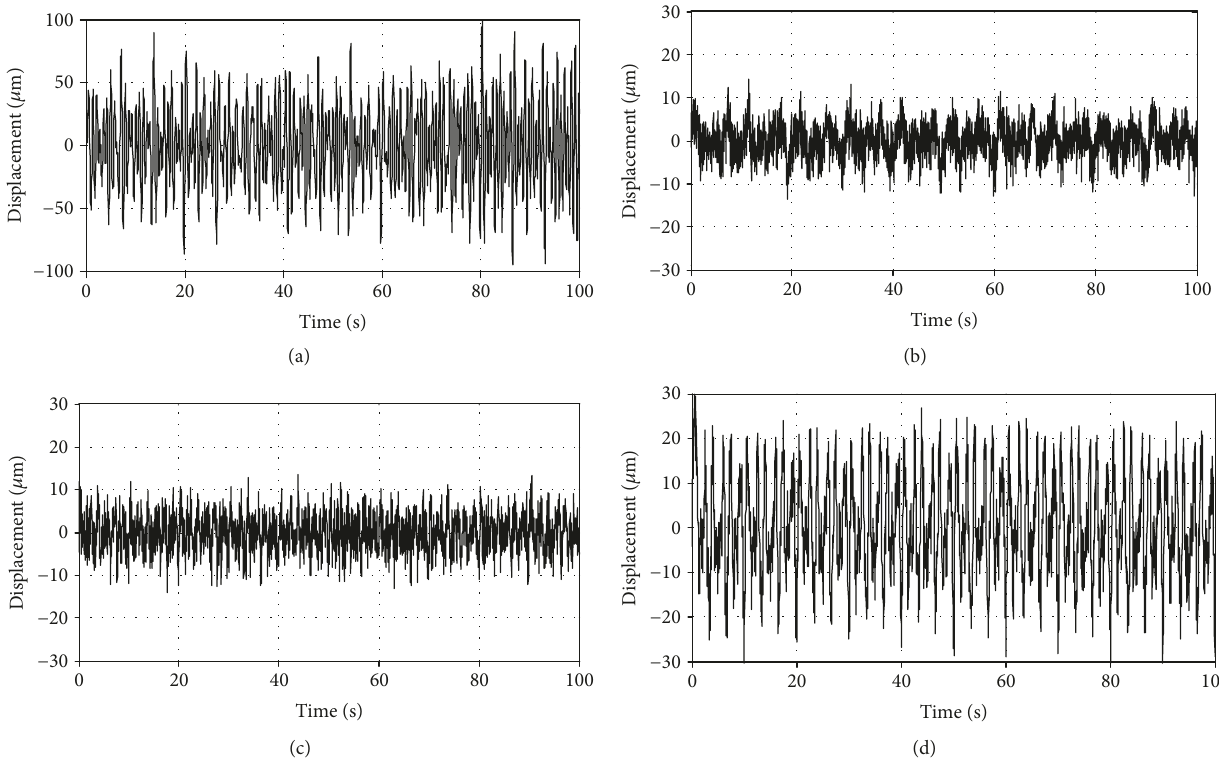
Figure 10: Displacement response to external disturbing force: (a) passive vibration isolation system, (b) AVIS with DCARC controller, (c) AVIS with DRC controller, and (d) AVIS with AC controller.